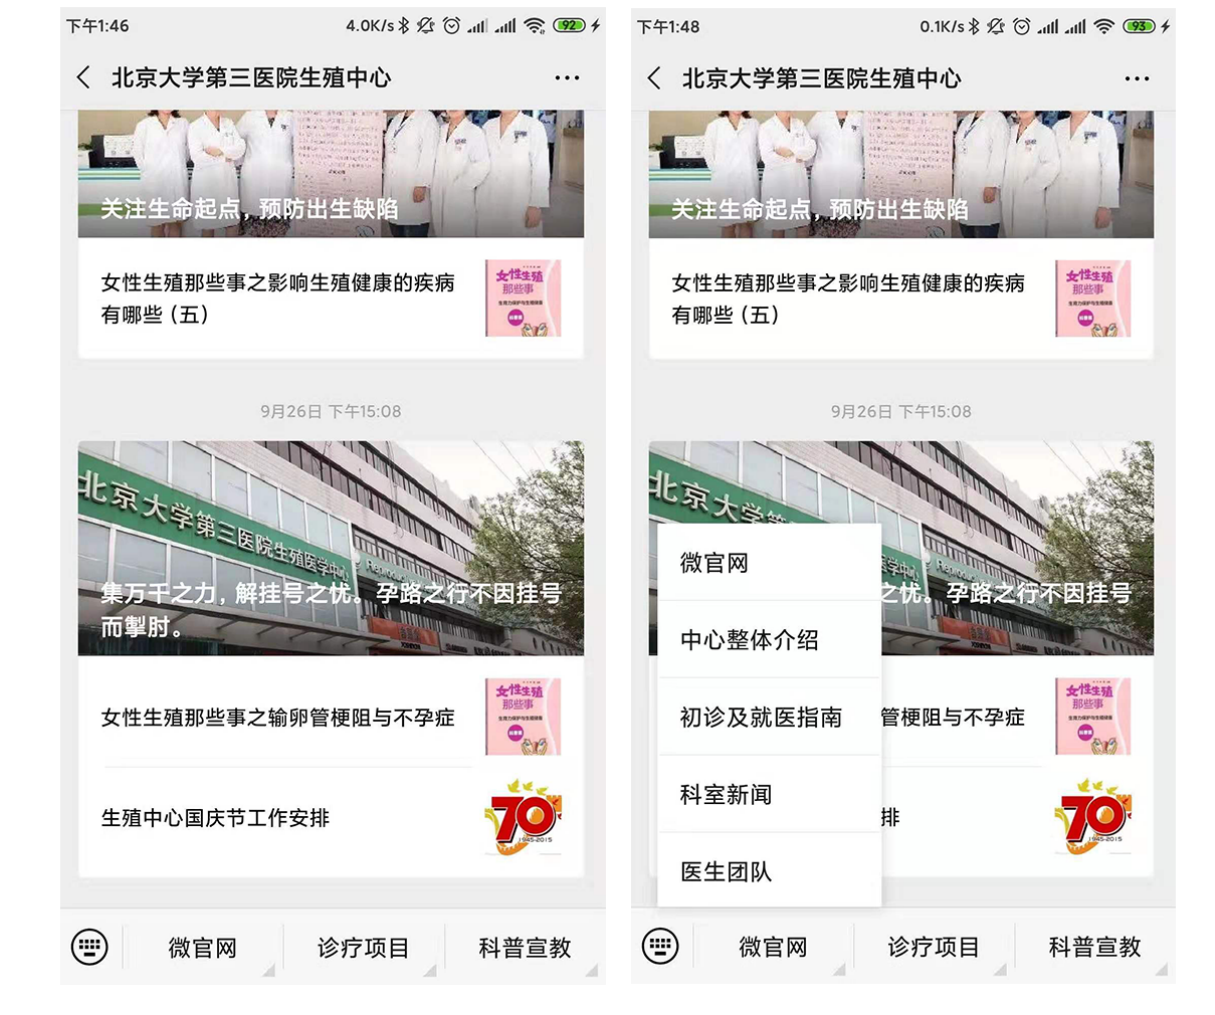
Figure 4. Profile of WeChat official accounts for assisted reproduction technology centers.